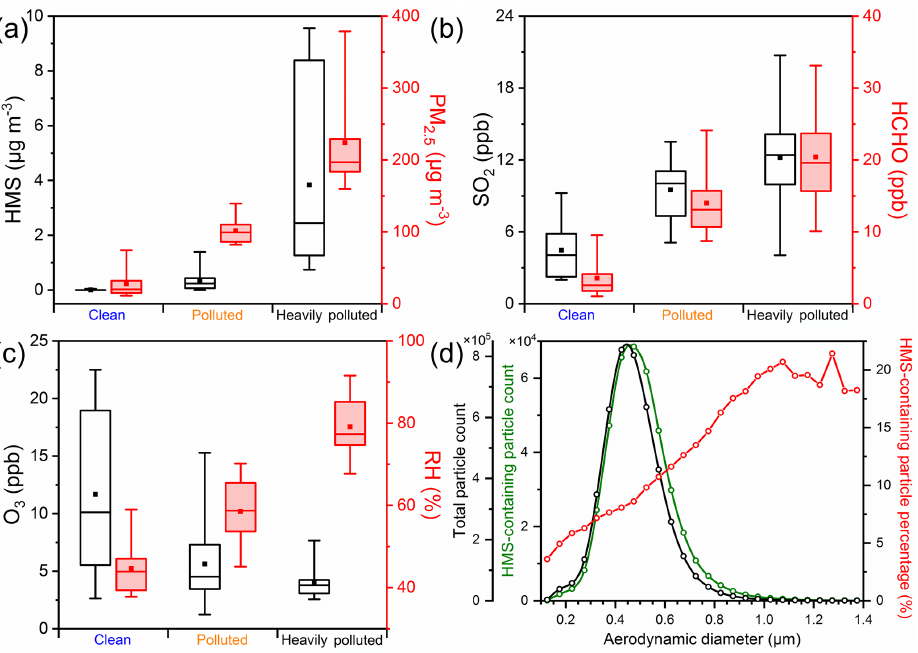
Figure 2. Evolution of HMS in Beijing winter of 2015. (a–c) Concentrations of HMS, PM 2 . 5 , SO 2 , HCHO, O 3 , and RH at different pollution levels from 26 November 2015 to 8 January 2016. In the box–whisker plots, the whiskers, boxes, and points indicate the 95th, 75th, 50th, 25th, 5th percentiles, and mean values. (d) Size distribution of HMS-containing particles from 21 December 2015 to 8 January